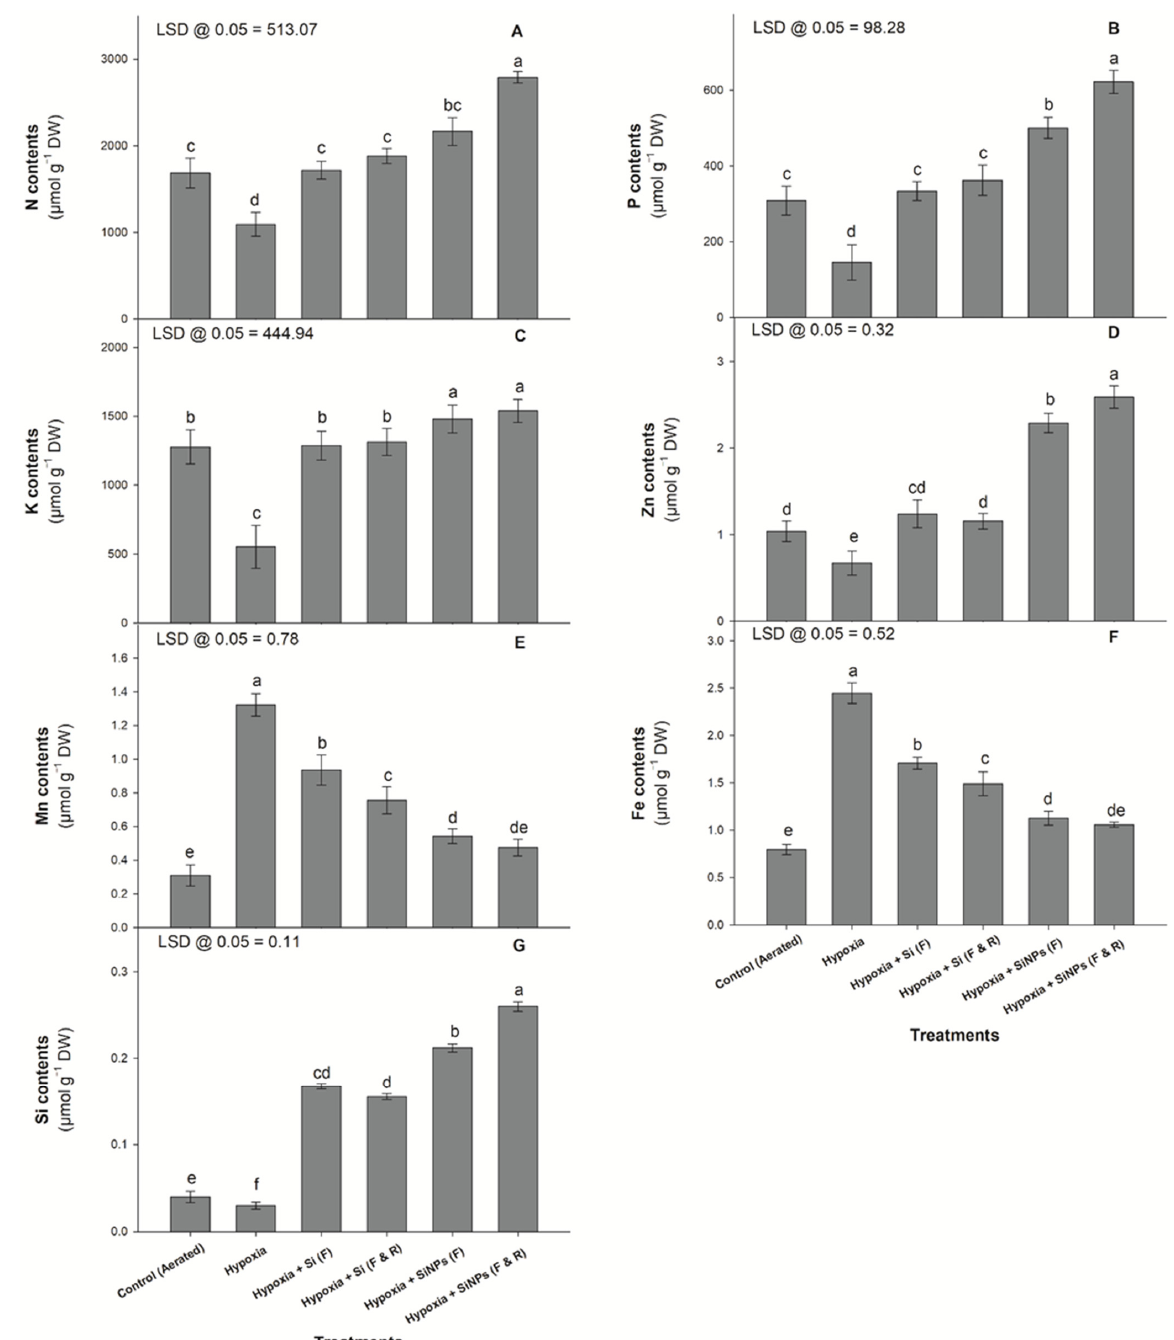
Figure 8. N ( A ), P ( B ), K ( C ), Zn ( D ), Mn ( E ), Fe ( F ), and Si ( G ) contents in leaves of blueberry plants grown in response to six treatments i.e., (i) control (aerated), (ii) hypoxia, (iii) hypoxia + Si (F), (iv) hypoxia + Si (F & R), (v) hypoxia + SiNP (F), (vi) hypoxia + SiNPs (F & R). Values are mean of four independent replicates ( n = 4) ± SE (shown in vertical bars), and values denoted by different letters (in small alphabets) differ significantly at p < 0.05, using the LSD test. The abbreviations used are F: foliar application of Si or SiNP; F & R: combined foliar and root zone application of Si; Fe: iron; K: potassium; Mn: manganese; N: nitrogen; P: phosphorus; R: root zone application of Si or SiNP; Si: conventional silicon; SiNPs: silicon nanoparticles; Zn: